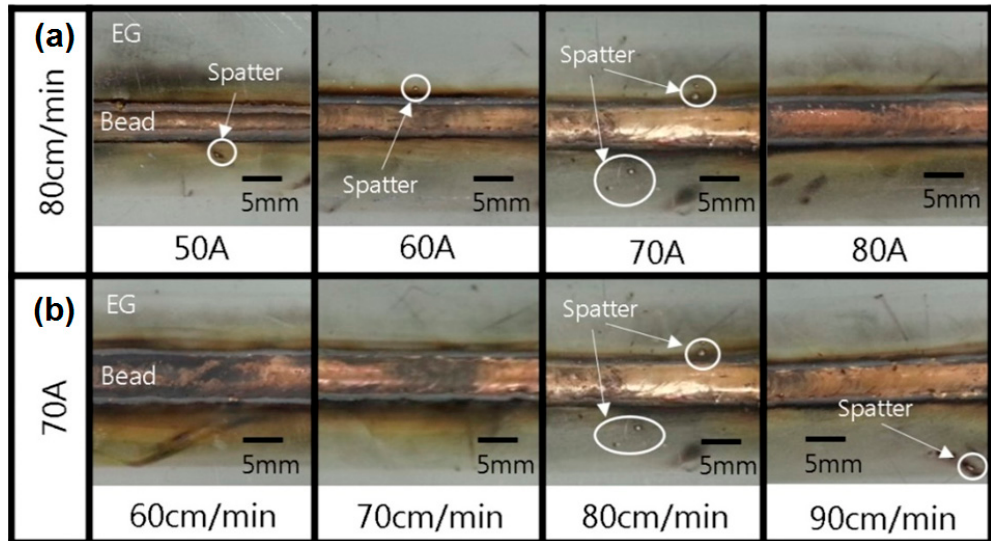
Figure 4. Bead appearance. ( a ) arc current (at 80 cm/min), and ( b ) brazing speed (at 70 A).